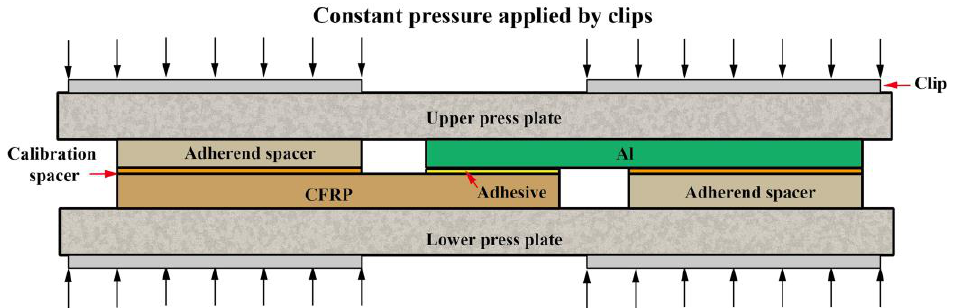
Figure 2. Configuration for fabrication of single-lap joints.